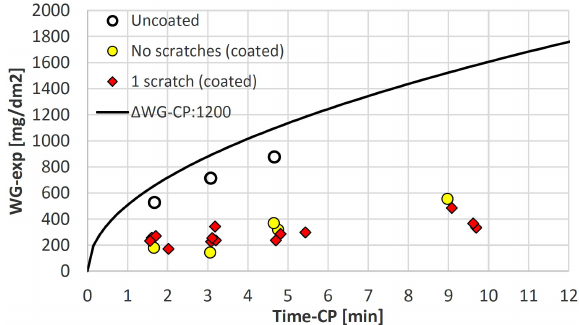
Figure 8. Results of weight-gain.